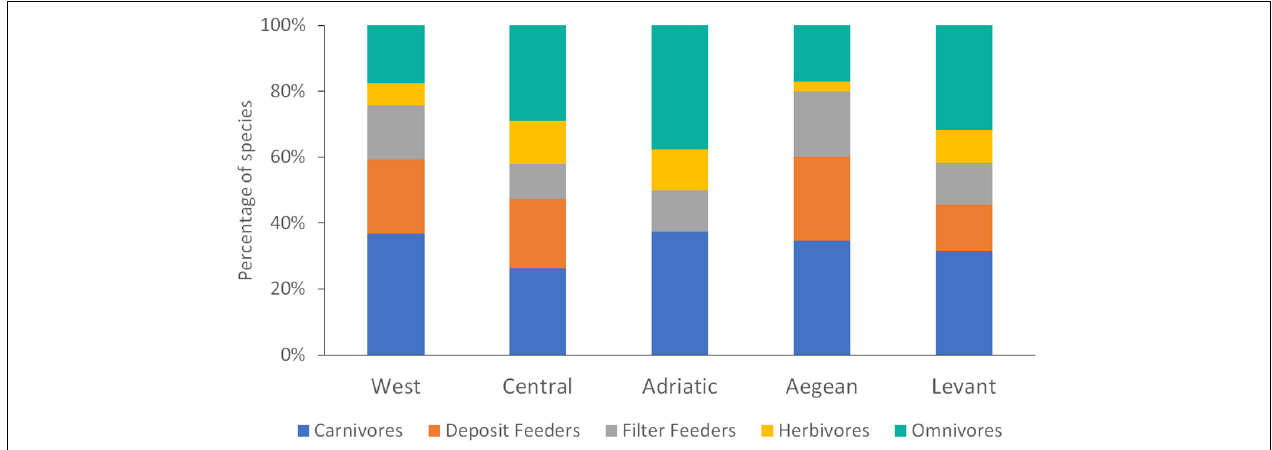
FIGURE 6 | The trophic composition of sponge-associated polychaetes found in five regions of the Mediterranean Sea.